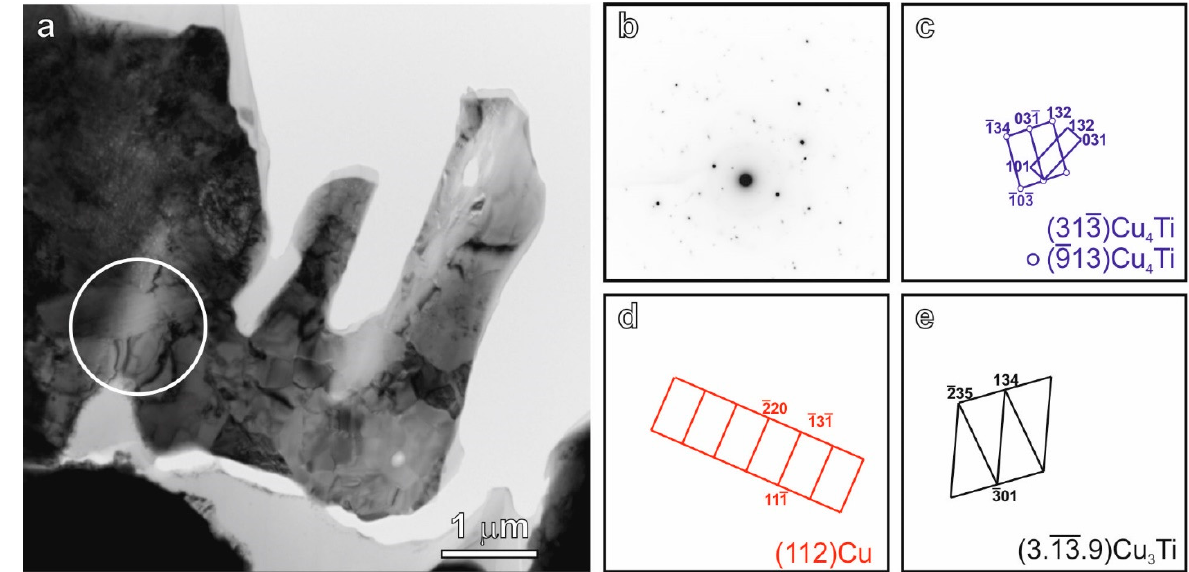
Figure 4. TEM images of the surface layer of the copper alloy treated by titanium ions (6 min): gen- eral views of the cross-section of the modified surface ( a ), microdiffraction patterns and schemes of their indexing ( b , c ).